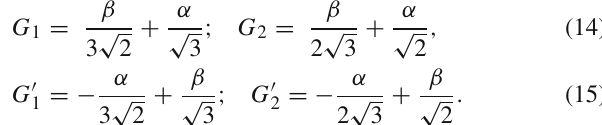
figuration. Specifically, | 000 (cid:4) is the spin-0 tetraquark con- ¯ 3 c and spin-0 antidiquark structed from spin-0 diquark in in 3 c , while | 011 (cid:4) is the spin-0 tetraquark constructed from ¯ 6 c . In each spin-1 diquark in 6 c and spin-1 antidiquark in isospin channel, the two numerical factors partially cancel in Eq. (1) to make the heavy nonet but they add up in Eq. (2) to make the light